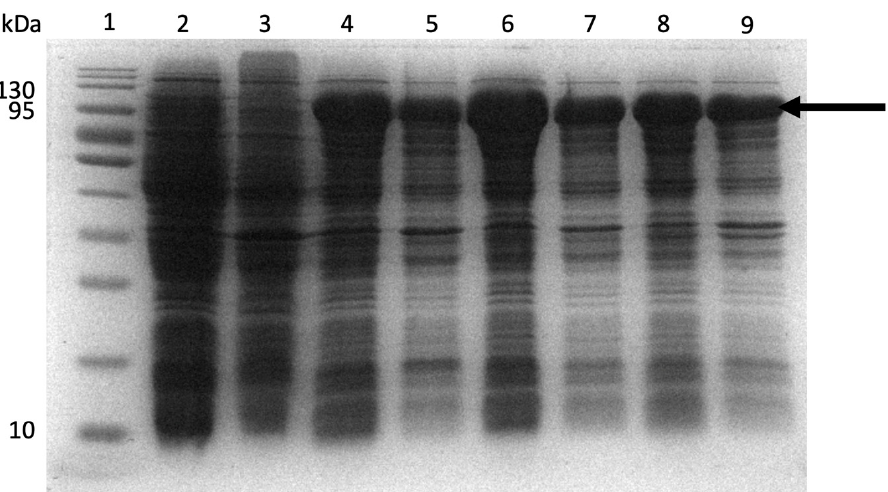
Figure 13. ClpK expression using varying IPTG concentrations. Protein expression was induced with varying IPTG concentrations (0.1 mM, 0.25 mM and 0.5 mM) at 15 °C for 24 h. Following expression, the culture was harvested by centrifugation. The resulting pellet was resuspended in lysis buffer, sonicated and analysed for soluble and non-soluble protein on a SDS-PAGE gel. Lane 1: molecular weight marker; Lane 2 and Lane 3: uninduced supernatant (Sn) and uninduced pellet, respectively. Lane 4: 0.1 mM Sn; Lane 5: 0.1 mM pellet; Lane 6: 0.25 mM Sn; Lane 7: 0.25 mM pellet; Lane 8: 0.5 mM Sn; Lane 9: 0.5 mM pellet. The arrow indicates the position of the expected protein.